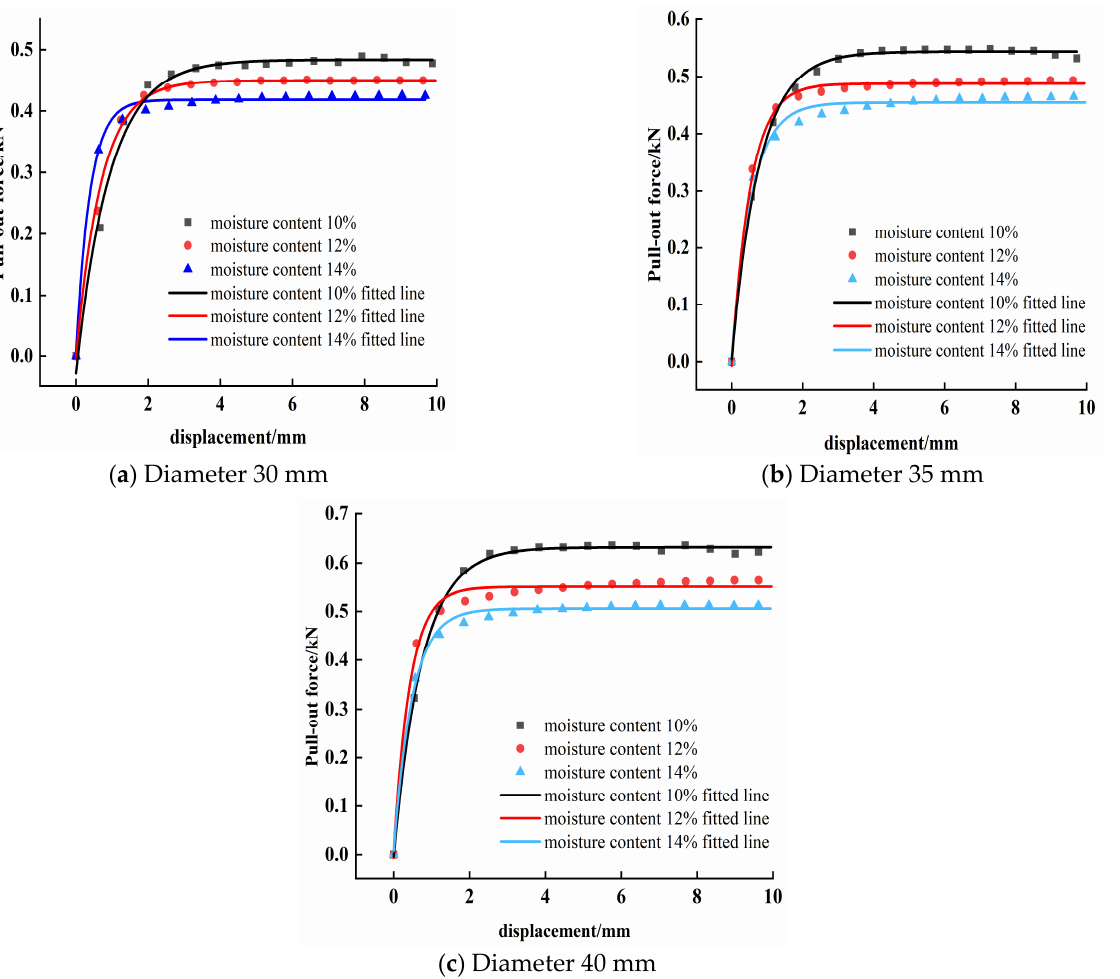
Figure 8. Uplift bearing capacity–displacement curves of anchors with different water contents.